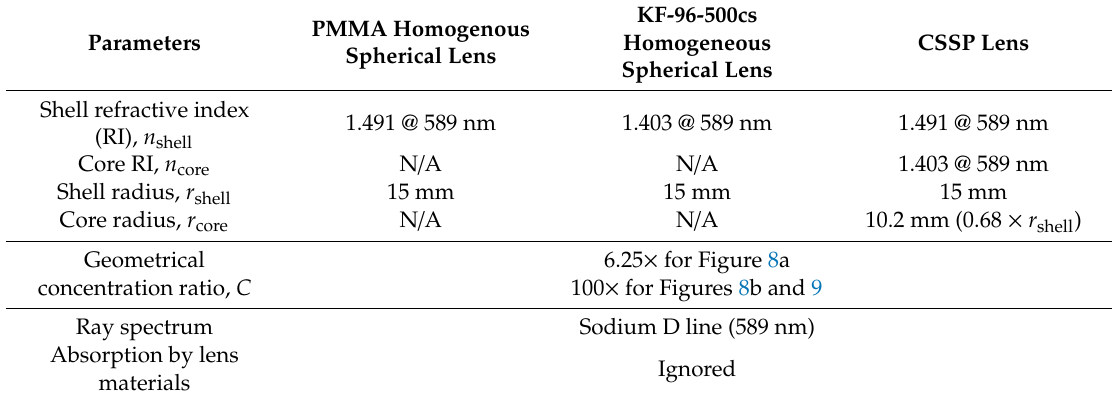
Table 1. Simulation conditions A.